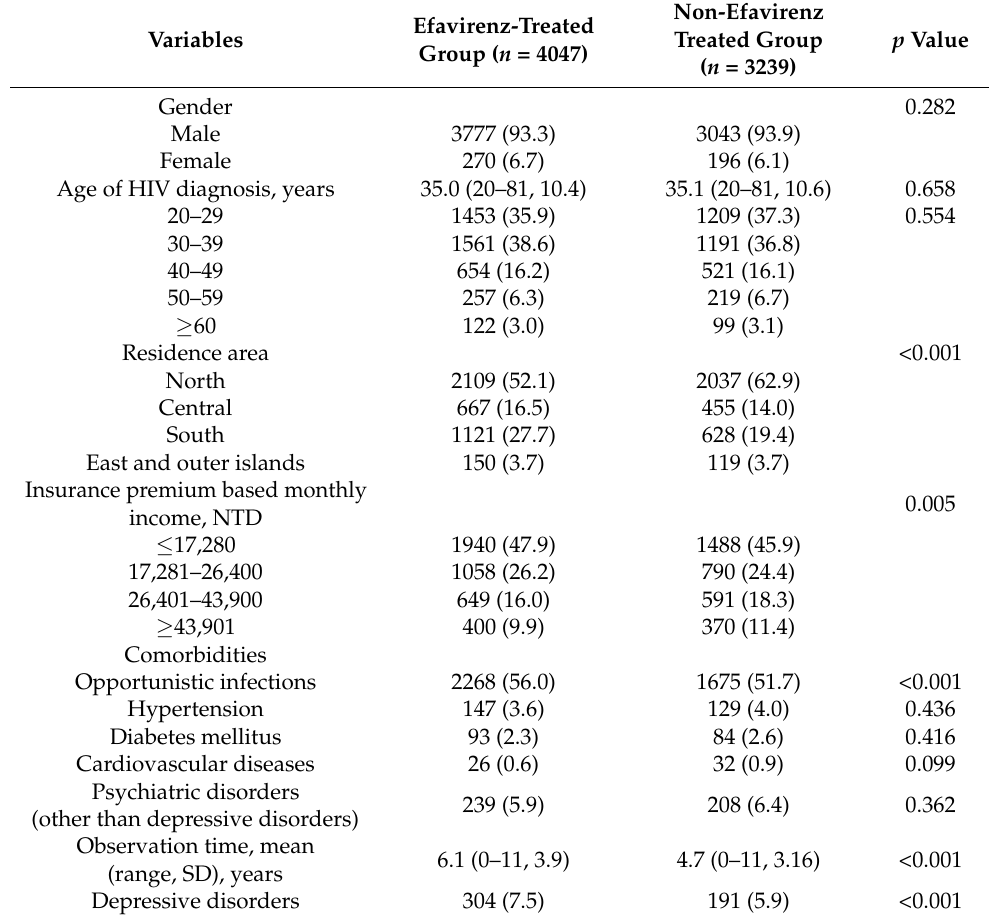
Table 1. Demographic characteristics of HIV-infected patients, with or without efavirenz